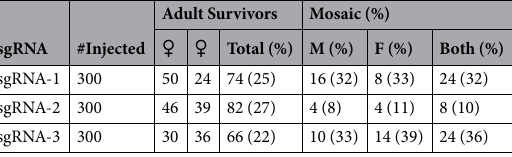
Crossing strategy